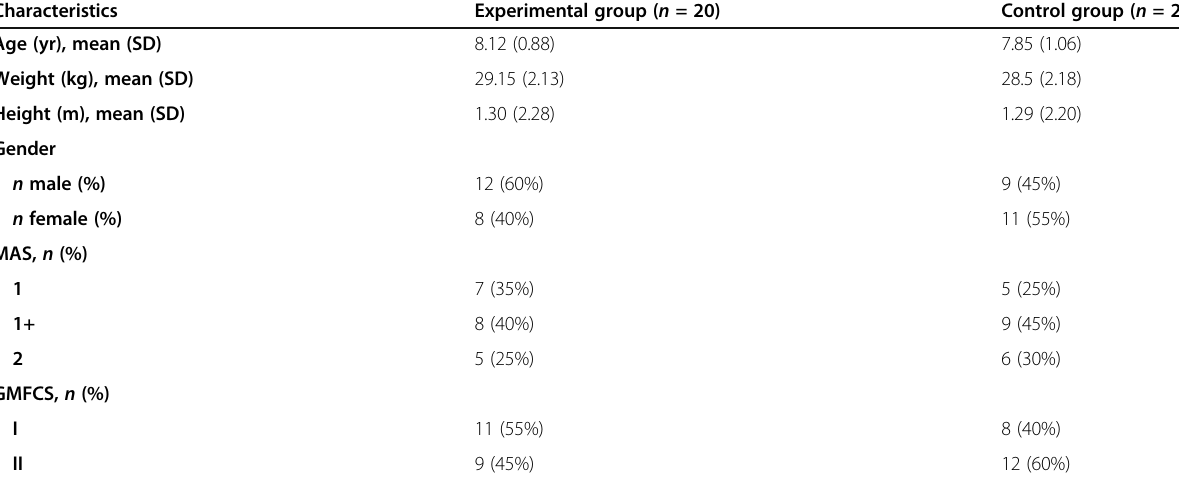
Table 1 Pre-treatment characteristics of participants Characteristics